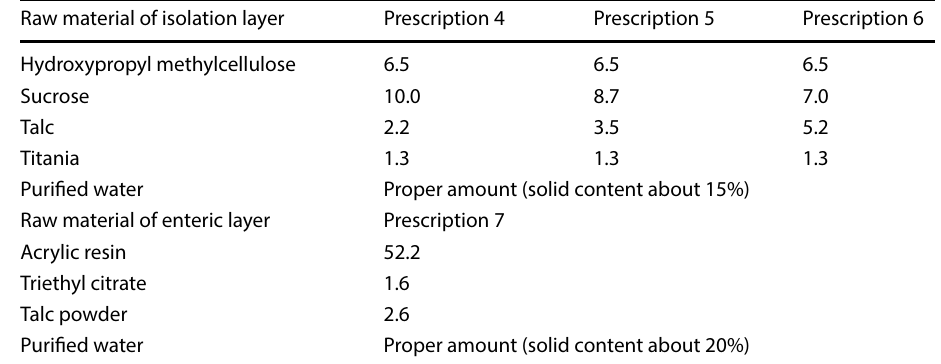
Table 2 Composition of isolation layer and enteric layer (calculated as 1000 tablets, unit: